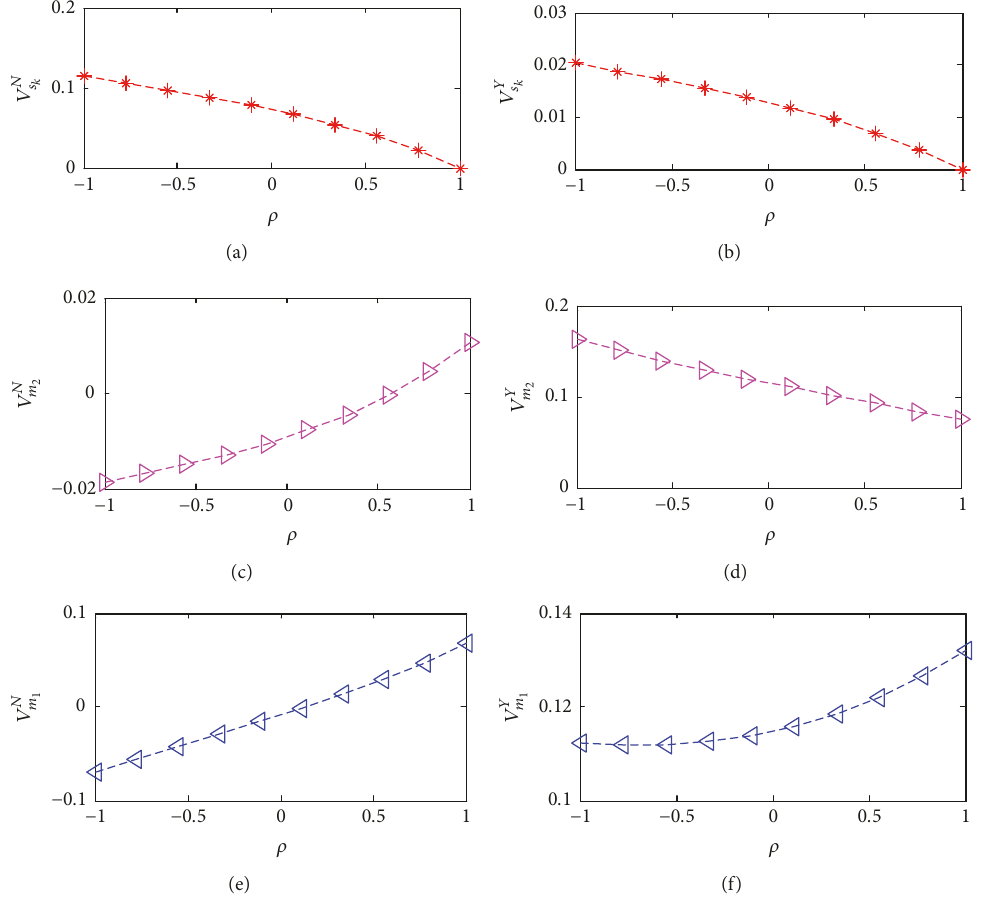
Figure 1: The effect of 𝜌 on 𝑉 𝑁 𝑠